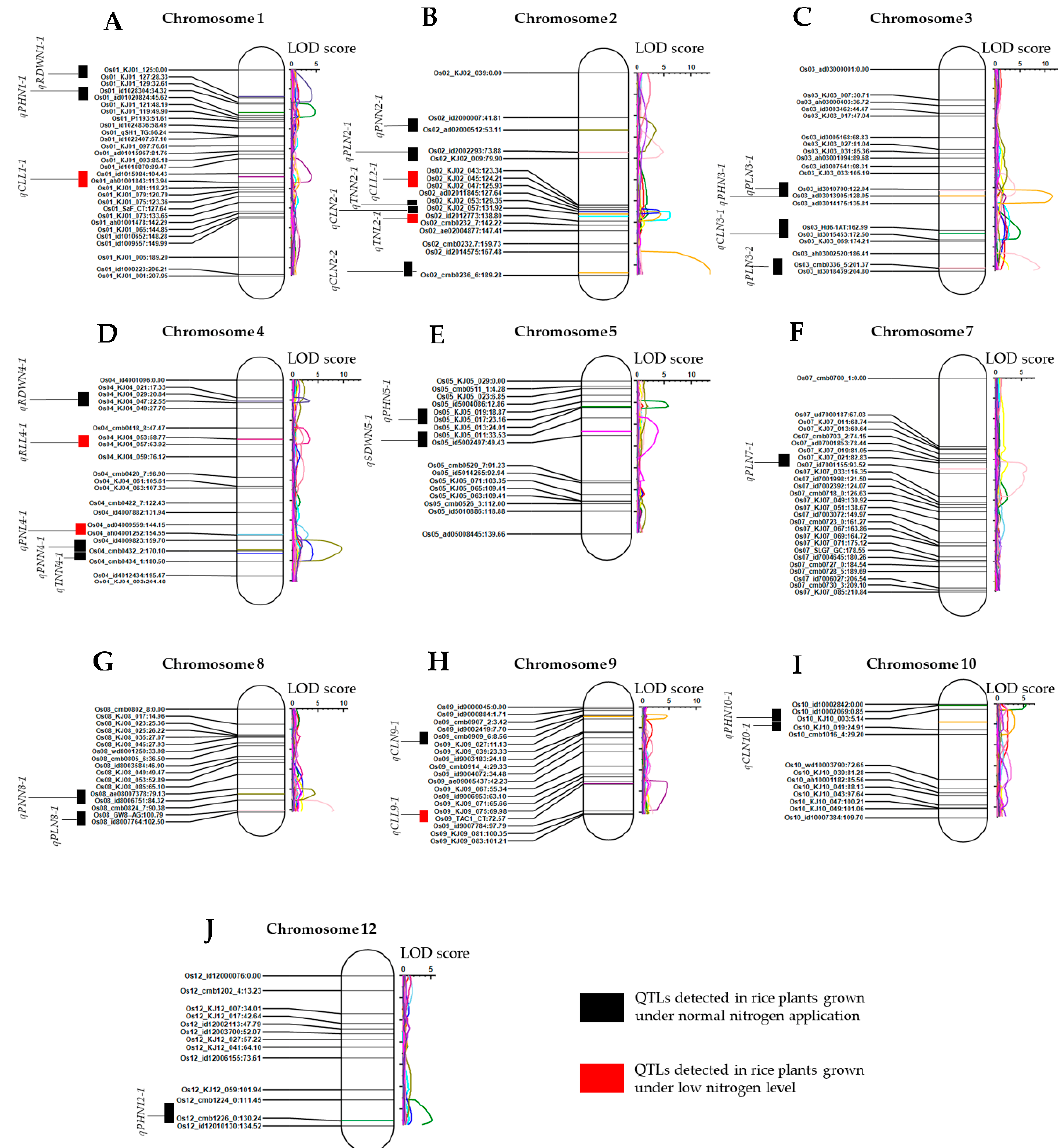
Figure 4. Linkage maps and identified QTLs associated with various agronomic traits in rice under normal and low nitrogen cultivation. Five (5) QTLs ( qPHN-1 , 43 cM; qPHN3-1 , 166 cM; qPHN5-1 , 23 cM; qPHN10-1 , 1 cM; and qPHN12-1 , 130 cM) associated with plant height of rice were mapped on five (5) different chromosomes, for normal nitrogen cultivation. The QTLs associated with tiller number were mapped on chromosome 2 ( qTNN-1 , 130 cM for normal nitrogen cultivation, and qTNL2-1 , 134 cM for low nitrogen cultivation) and chromosome 4 ( qTNN4-1 , 173 cM). For both normal and low nitrogen cultivation conditions, five QTLs ( qCLN2-1 , 132 cM; qCLN2-2 , 187 cM; qCLN3-1 , 128 cM; qCLN9-1 , 9 cM; and qCLN10-1 , 17 cM) and two (2) QTLs ( qCLL1-1 , 108 cM; and qCLL9-1 , 72 cM) were mapped on four and two chromosomes, respectively. Five QTLs ( qPLN2-1 , 74 cM; qPLN3-1, 123 cM; qPLN3-2 , 201 cM; qPLN7-1 , 89 cM; and qPLN8-1, 101 cM) associated with panicle length under normal nitrogen cultivation were mapped on four chromosomes. Three QTLs ( qPNN2-1 , 53 cM; qPNN4-1 , 169 cM; qPNN8-1 , 84 cM) and one QTL ( qPNL4-1 , 154 cM) associated with panicle number were mapped on three chromosomes and one chromosome, for normal nitrogen and low nitrogen cultivation, respectively. A unique QTL ( qRLL4-1 , 59 cM) associated with root length was mapped on chromosome 4. Finally, one QTL ( qSDWN-51 , 46 cM) and two QTLs ( qRDW1-1 , 27 cM; and qRDW4-1 , 21 cM) associated with shoot dry weight (SDW) and root dry weight, respectively, under normal nitrogen cultivation, were mapped to chromosomes 5 (for SDW) and 1 and 4 (for RDW). ( A – J ) Chromosomes 1, 2, 3, 4, 5, 7, 8, 9, 10, and 12. LOD score, logarithm of the odds indicating the significance of genetic linkage between markers and the detected QTLs above a threshold.